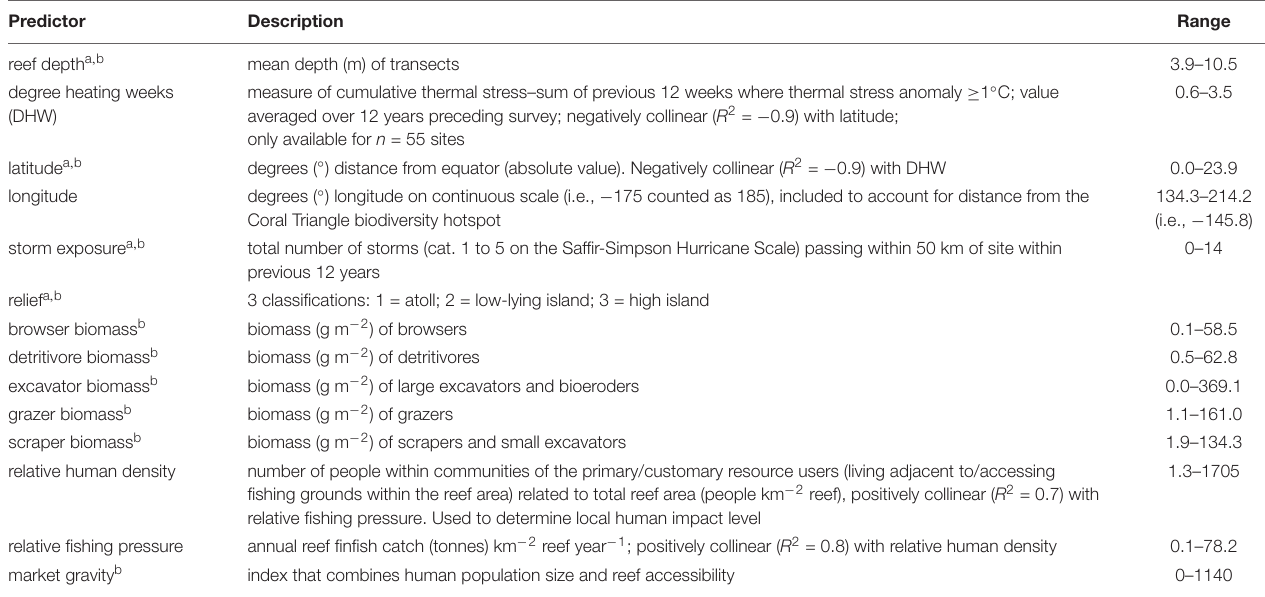
TABLE 2 | Predictor descriptions and ranges at outer